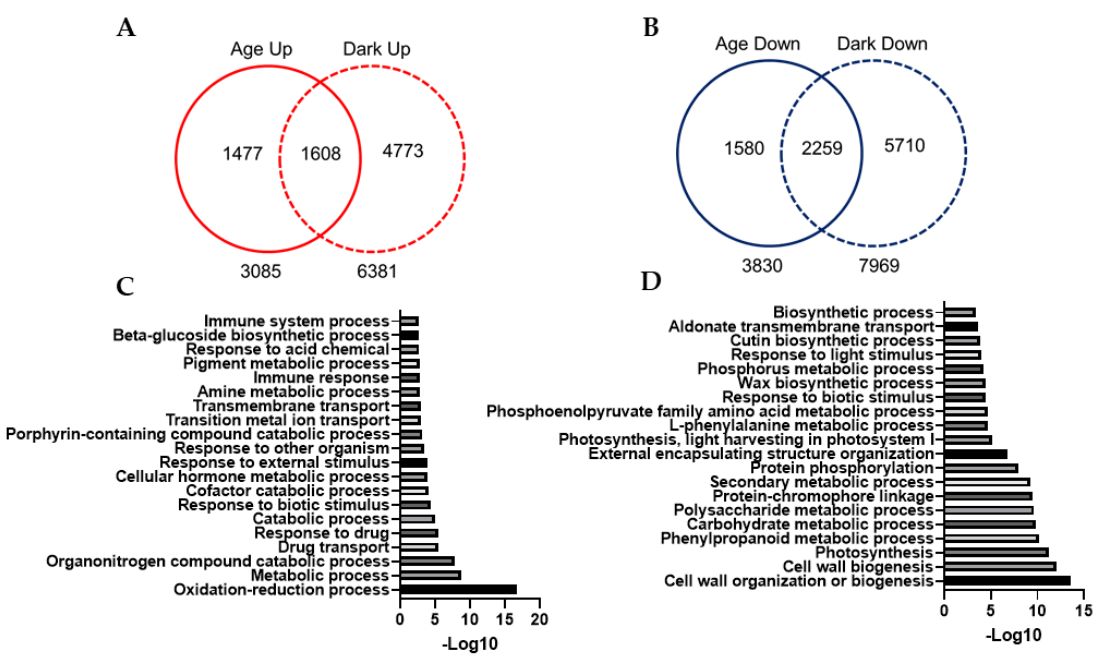
Figure 7. Comparison of age-dependent and dark-induced transcript profiles. ( A ) Venn diagram showing overlap among all the DE upregulated genes in age-dependent and dark-induced leaf senes- cence. ( B ) Venn diagram showing overlap among all the DE downregulated genes in age-dependent and dark-induced leaf senescence. ( C ) GO-term enrichment analysis of common upregulated genes during age-dependent and dark-induced leaf senescence. ( D ) GO-term enrichment analysis of common downregulated genes during age-dependent and dark-induced leaf senescence.